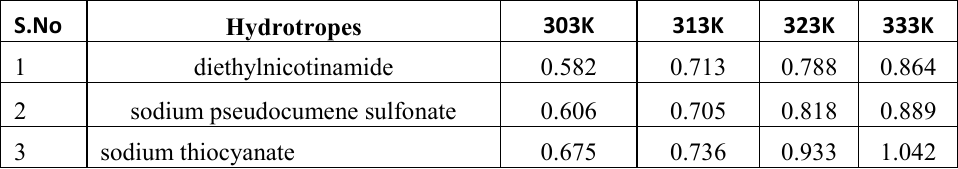
] values of hydrotropes with respect to m- s aminoacetophenone.